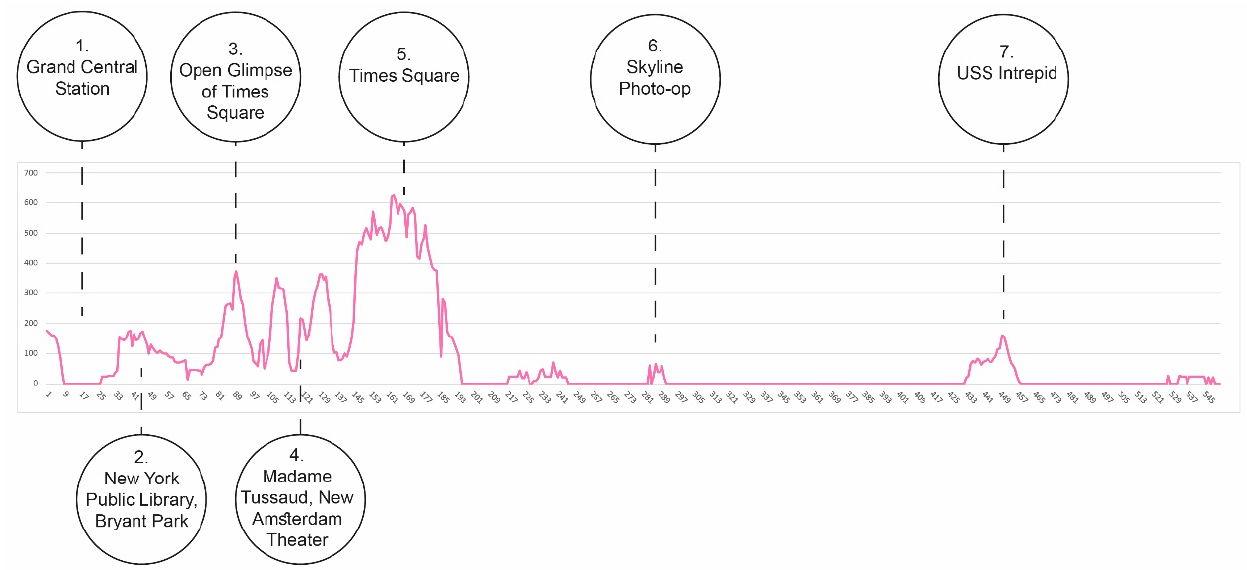
Figure 9. Geovisualization graphs of case study 1 showing the landmark category type (pink) visible from both routes: the shortest route ( top ) and tourism route ( bottom ). A simulation of the 3D visualization scenery from the pedestrian perspective in Times Square is depicted on the right.